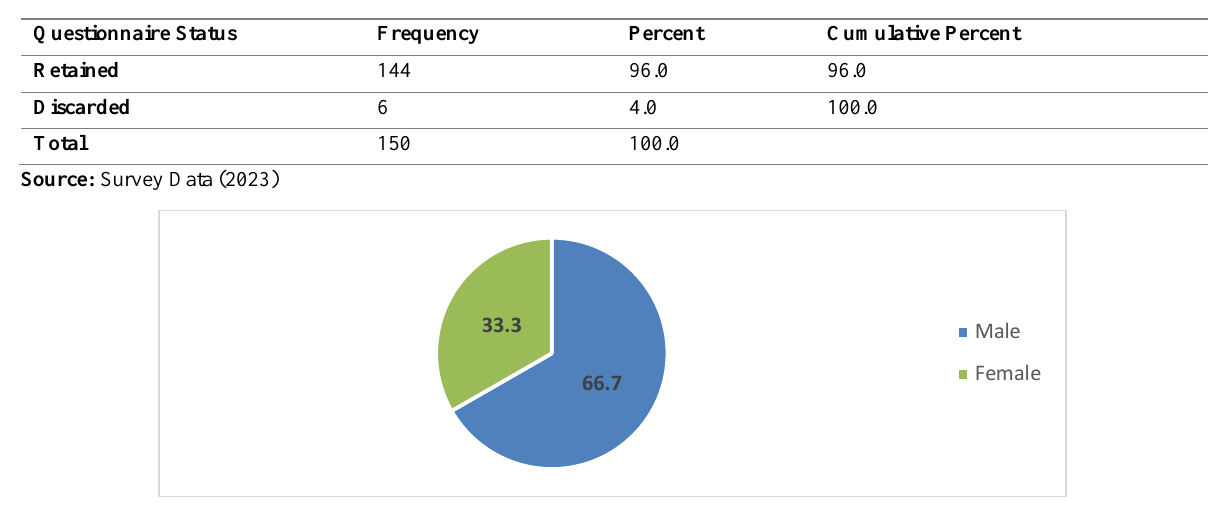
Table 1: Questionnaires Response Rate